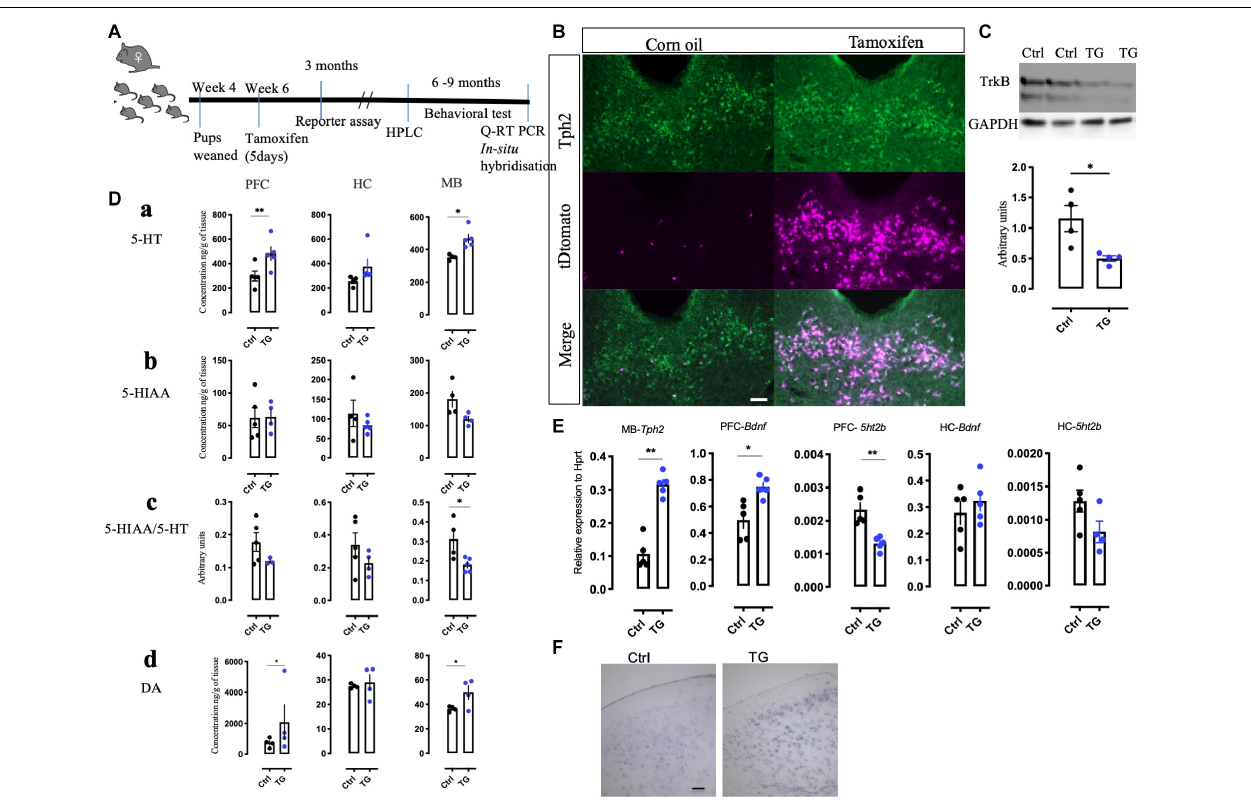
FIGURE 1 | Generation of conditional knockout mice, reporter expression and alteration of 5-HT and its metabolite in the transgenic mice. (A) An experimental scheme representing the time of injection, reporter assay, HPLC measurements and the duration when different behavioral battery tests were performed followed by molecular analysis. (B) Confirmation of Cre-recombination in the tDtomato reporter mice using immunohistochemistry with Tph2 antibody in tamoxifen injected and corn oil injected animals ( N = 4). (C) Western blotting with TrkB monoclonal antibody on the mid-brain samples from the control and TG mice ( N = 4). (D) (a) The total levels of 5-HT was measured by HPLC in naïve animal’s different brain regions such as the PFC, HC, and MB. The levels in TG mice were significantly upregulated in the PFC and MB. (b) The levels of 5HIAA did not change in these brain regions. (c) The 5HIAA/5-HT ratio was also measured in these regions. The ratio was significantly down regulated in the MB of the TG mice. (d) The levels of DA were significantly upregulated in the PFC and MB of the TG mice ( N = 4). (E) q-RT PCR results of the transcripts Tph2 in the MB and Bdnf in the PFC was increased. The transcript for 5ht2b was reduced in the PFC of the TG mice. No change in Bdnf and 5ht2b transcripts in the HC was observed ( N = 4). (F) In situ hybridization with Bdnf probe in the PFC of Ctrl and TG mice shows a robust expression ( N = 3). Scale bar represents 100 µ m, Student’s t -test, * p -value < 0.01, ** p -value < 0.01. HPLC-High pressure liquid chromatography, 5-HT-